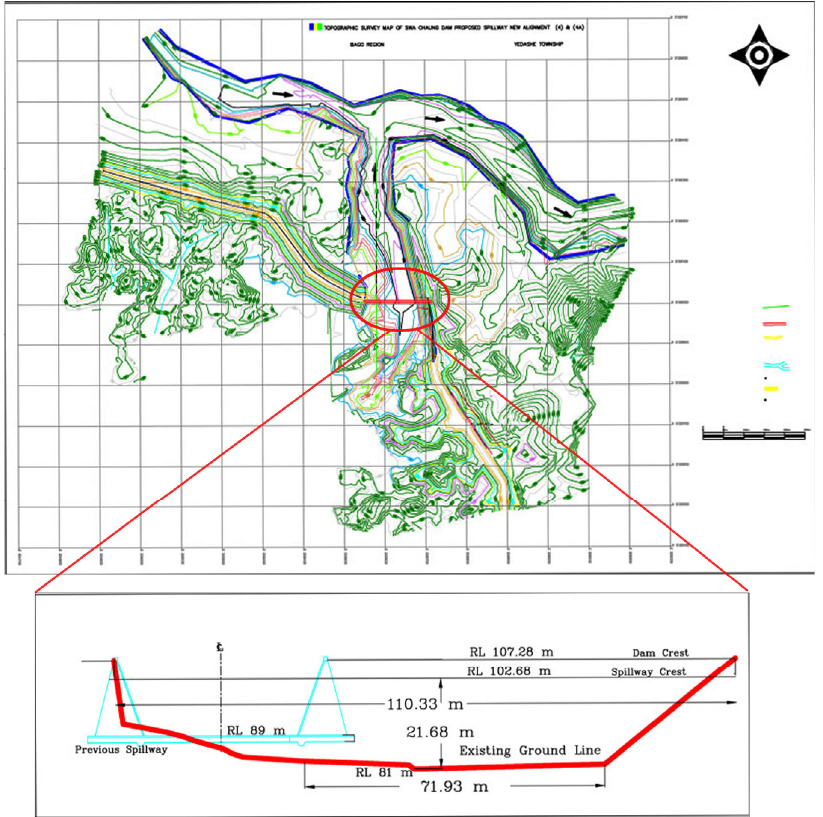
Figure 7. Breach dimensions from the topographic survey data (after the event) (IWUMD).